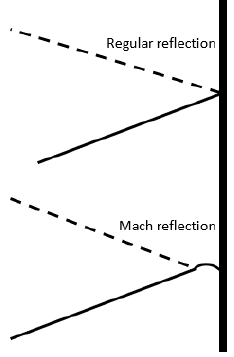
Figure 3. Regular and irregular (Mach) wave reflection.